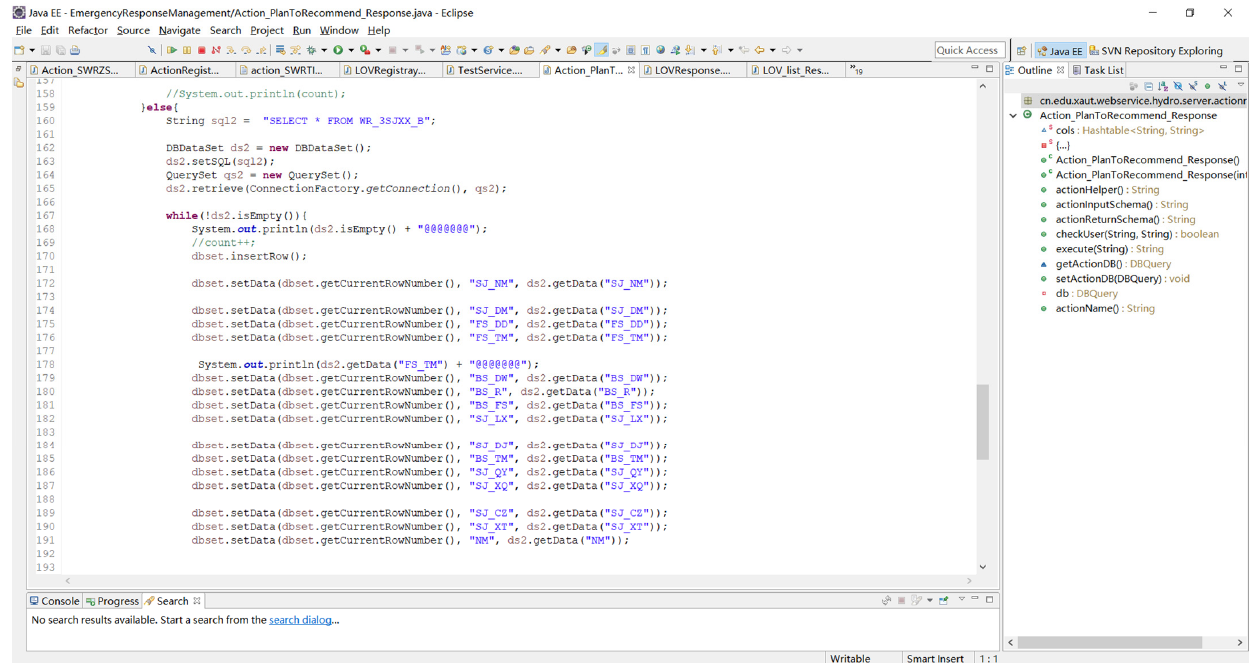
Figure 5. Part of the code for the development process.